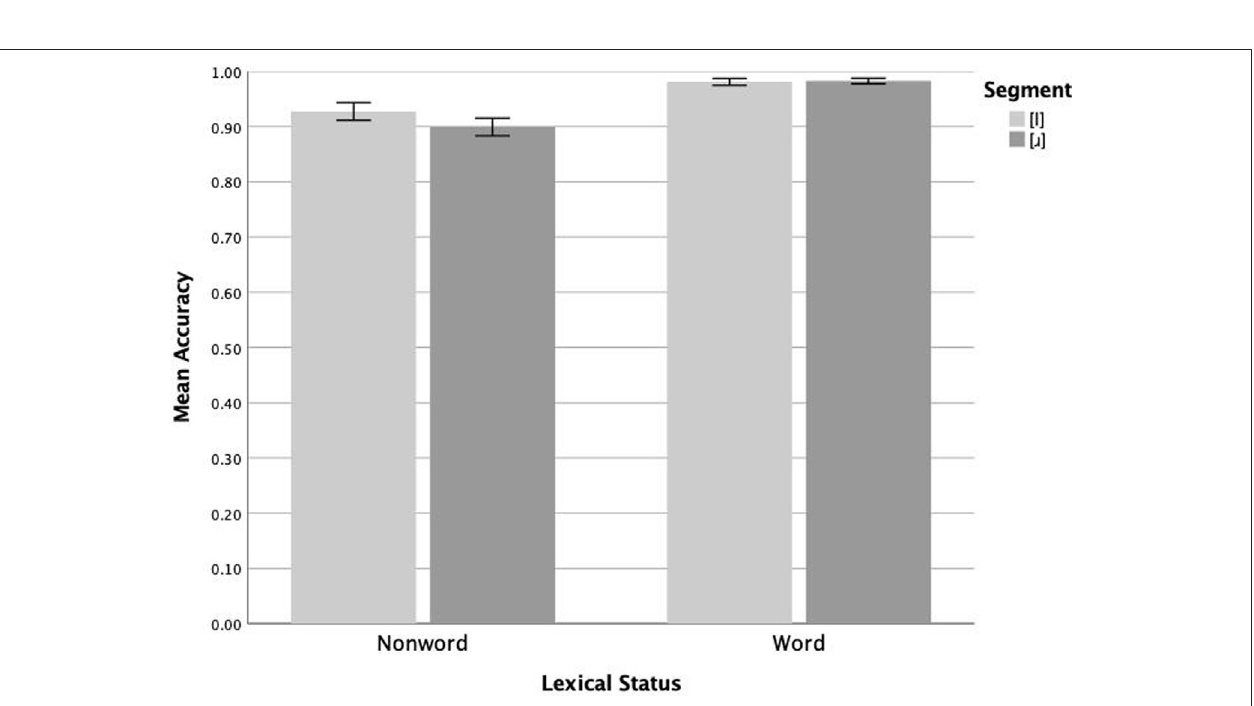
FIGURE 2 | Mean lexical decision accuracy (proportion correct) on [l] and [ ɹ ] items by native English speakers ( n (cid:1) 56). Whiskers represent 1 SE.